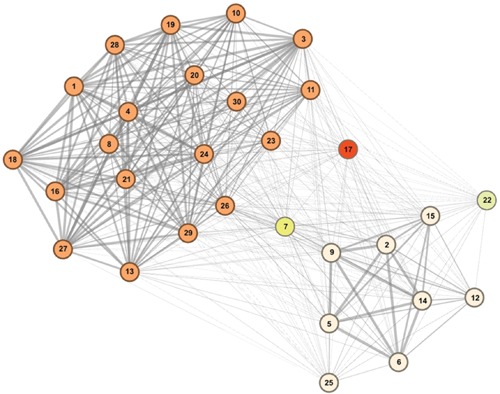
Mice within overall social hierarchy establish separate hierarchically organized communities. Community detection determined 19 individuals to belong to community A (orange), eight individuals to belong to community B (cream) and three individuals to not conclusively belong to either community. Tie strength is equivalent to the proportion of times that each subject pair were identified to belong to the same community from bootstrapped replications of original data (See Materials and Methods). Numbers refer to I&SI ranks.